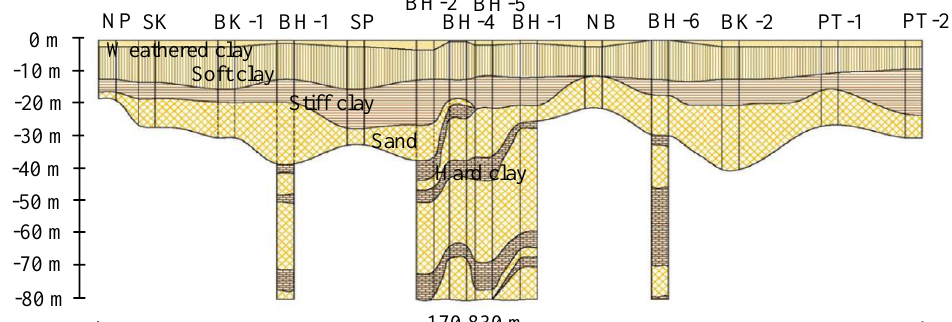
Figure 4. Soil profile layout of Zone D.